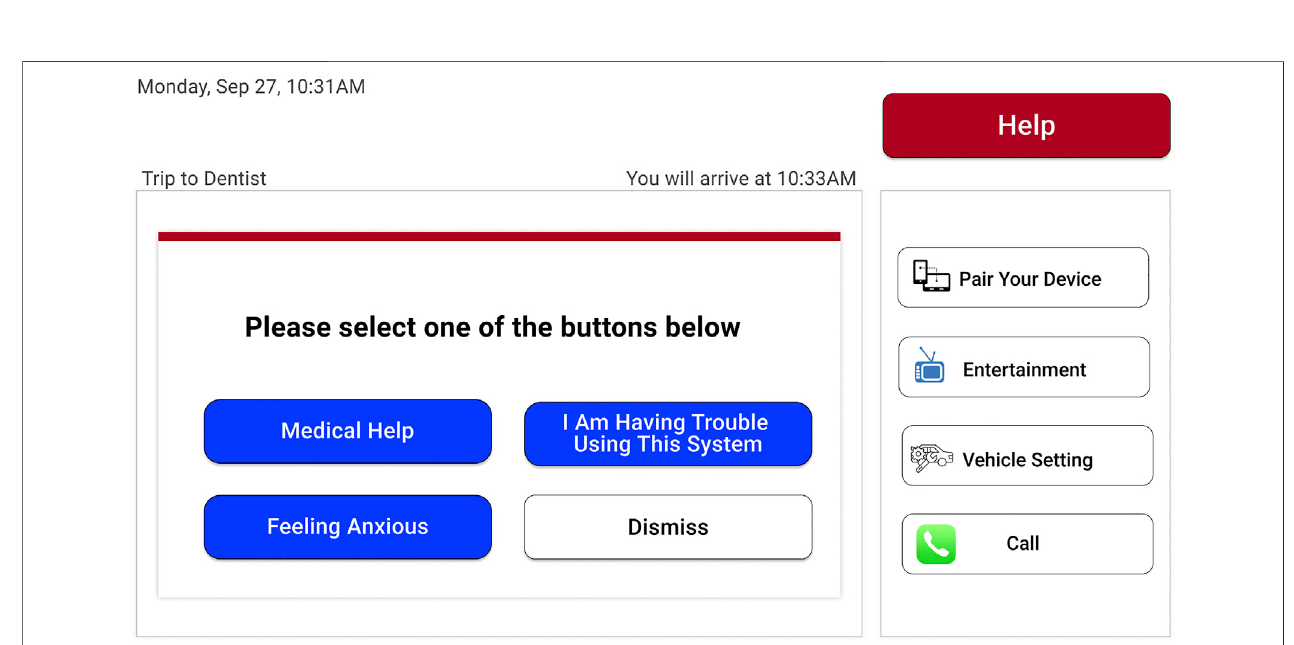
FIGURE 2 | Prototype of the help button